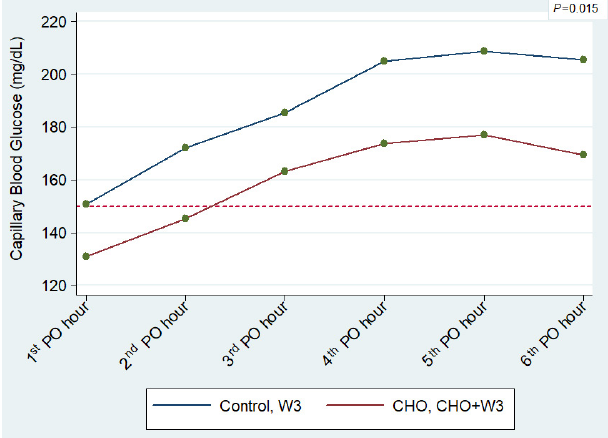
Fig. 6 - Average capillary blood glucose levels during the first 6 postoperative hours in the ICU, according to a new grouping: fasting abbreviation with CHO (CHO and CHO+W3) vs. groups receiving abbreviation with water (Control and W3). Note: the dotted line indicates the 150 mg/dL limit and the regular use of exogenous